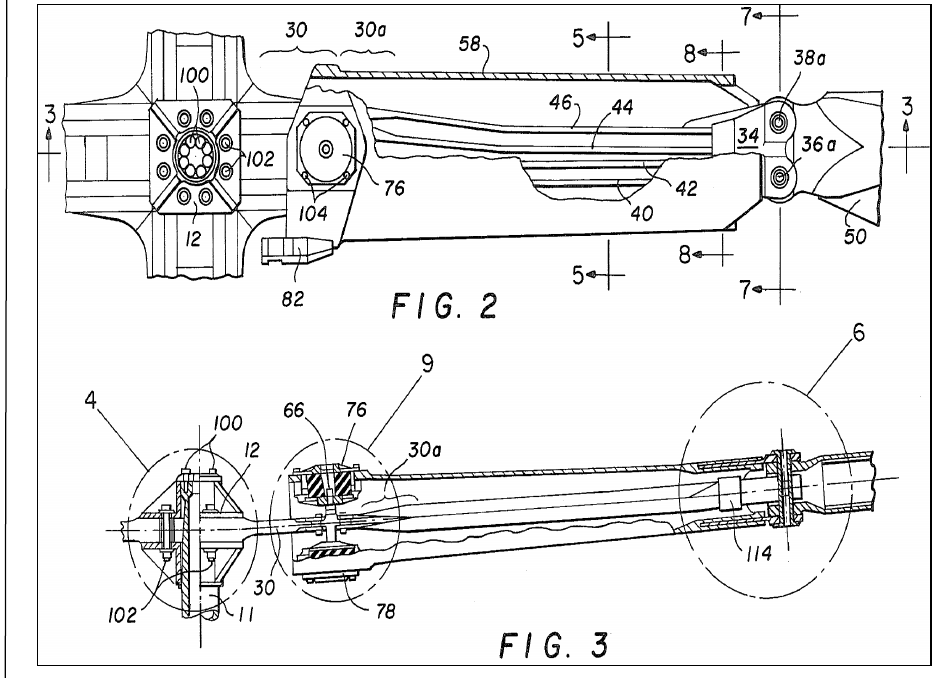
Figure 8 – Draft of a rigid rotor head in two projections (top and front) of the Bell company displayed in the application US4427340(A) Рис . 8 – Схема жесткого соединения лопастей и роторной головки компании Bell представлено в двух проекциях в приложении US4427340 ( А